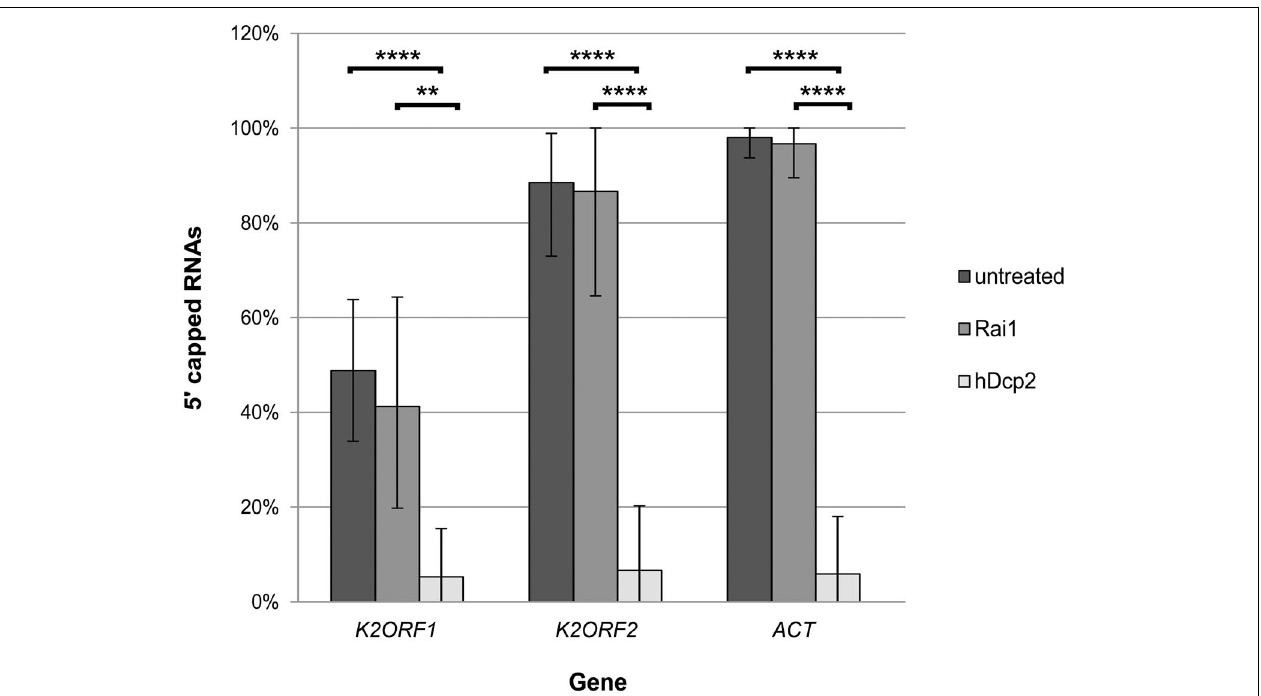
FIGURE 8 | The 5 (cid:48) ends of pGKL mRNAs are capped with the N7-methyl guanosine. Total RNA prepared from K. lactis IFO1267 was used for this experiment. The RNA was untreated (dark gray) or treated with either the Rai1 (middle gray; removes unmethylated 5 (cid:48) mRNA caps only) or hDcp2 (light gray; removes both methylated and unmethylated 5 (cid:48) mRNA caps) mRNA decapping enzymes. The presence of 5 (cid:48) RNA caps after incubation was monitored using 5 (cid:48) RACE followed by cloning and sequencing of individual cDNA clones. Bars represent the frequency (in %) of 5 (cid:48) RNA capping, with the error bars depicting the 95% confidence intervals calculated using the adjusted Wald method. The results were statistically evaluated using two-tailed Fisher’s exact test with a 95% confidence interval. ∗∗ Significance level p < 0.01; ∗∗∗∗ significance level p < 0.0001. The 5 (cid:48) RACE analysis of independent cDNA clones is summarized in Supplementary Table S12 . The results clearly show that pGKL mRNAs were resistant to decapping by Rai1, similar to the actin control, whereas all tested mRNAs were significantly decapped by